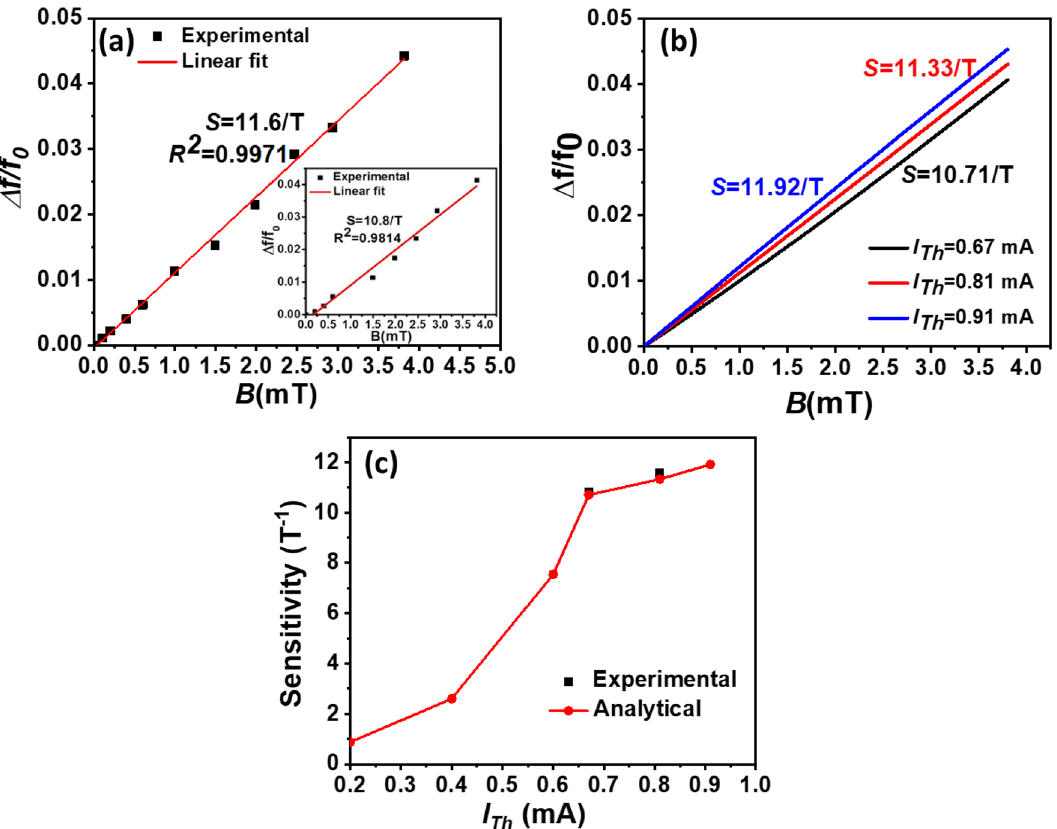
Figure 4. ( a ) Experimental results of the normalized resonance frequency variation versus input magnetic field for I Th = 0.81 mA. The inset shows the normalized resonance frequency shift versus input magnetic field for I Th = 0.67 mA. The slope of the plot presents the sensitivity of the device ( S ). ( b ) Analytical results of the variation of the normalized resonance frequency shift of the micro-beam for different I Th values. ( c ) Experimental and analytical results of S versus I Th